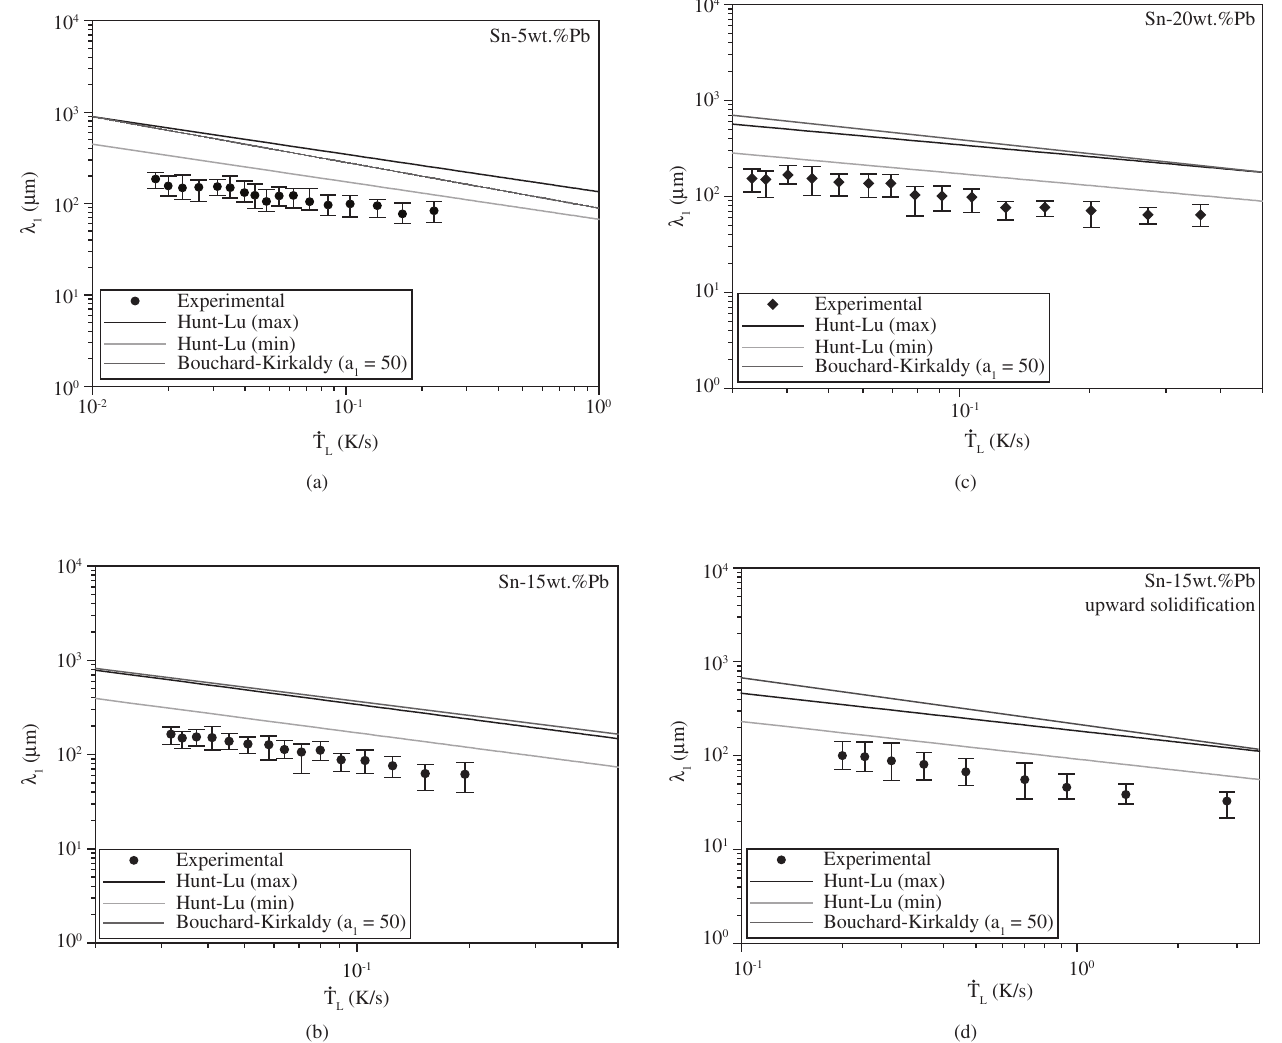
Figure 4. Comparison of experimental and theoretical primary dendrite arm spacing as a function of tip cooling rate for a) Sn-5wt.%Pb; b) Sn-15wt.%Pb; c) Sn-20wt.%Pb alloys in downward unsteady-state directional solidification; and d) Sn-15%Pb upward directionally